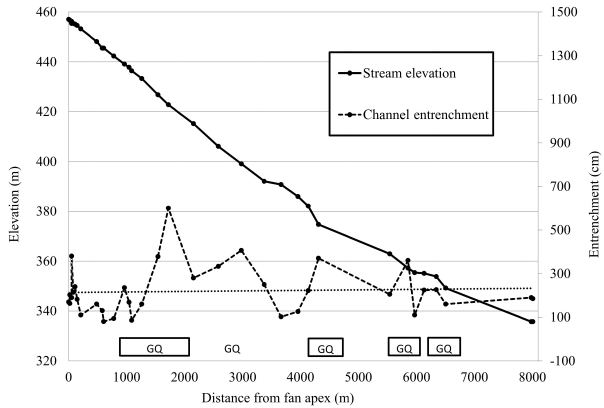
Figure 5. Nogalte River longitudinal profile and its channel banks entrenchment and related presence of gravel quarries